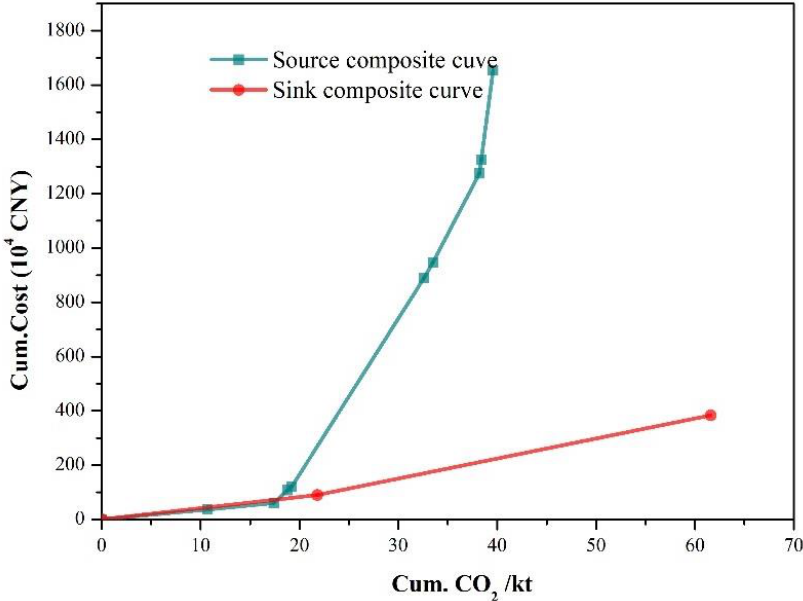
Figure 7. Source–sink curve of the tobacco industry for Scenario 3. The sink composite curve was then shifted horizontally to the right until it